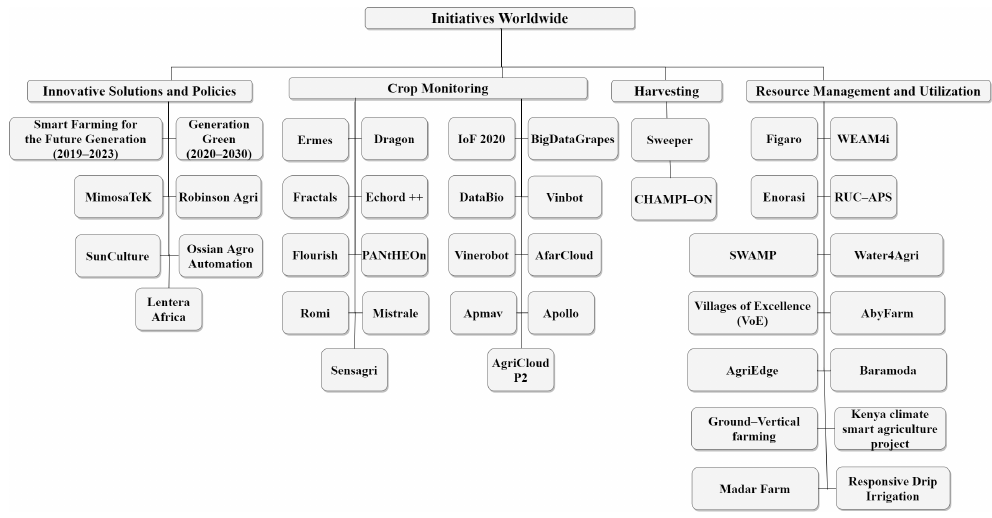
Figure 5. Smart Farming initiatives